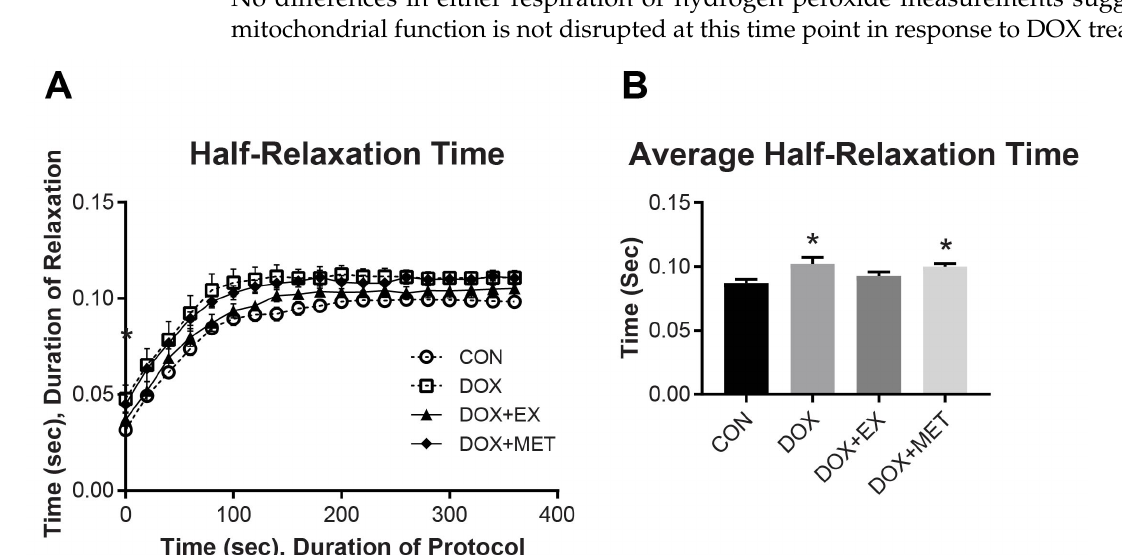
Figure 2. The half-relaxation time of GPS complex over 6 min fatiguing protocol. ( A ) Half-relaxation time over 6 min protocol. ( B ) The average half-relaxation time over the entire 6 min fatiguing protocol. Data are represented as mean ± SEM ( n = 7–10). Statistical differences ( p < 0.05) from CON are indicated by an asterisk (*).